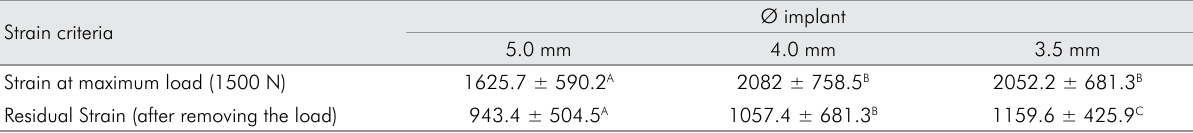
Table 3. The mean internal strain values (µS) ± SDs and statistical categories defined via Tukey’s test (n = 10) according to the formula ε A/B = (b² + a²) / 2a².